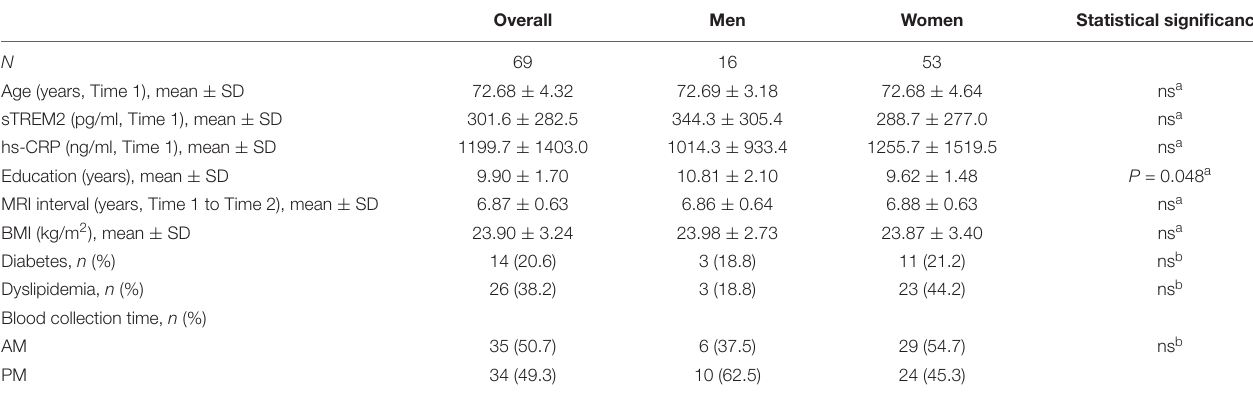
TABLE 1 | Participant